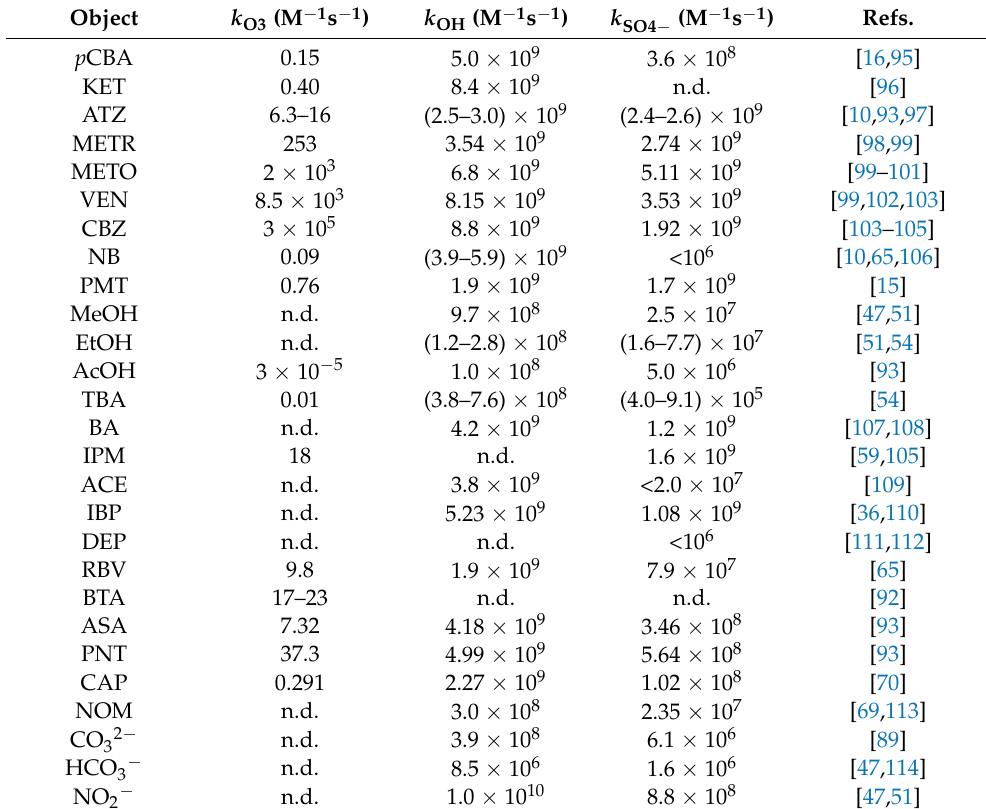
Table 3. The reaction rate constant between the substance and O 3 , • OH and SO 4 •− .